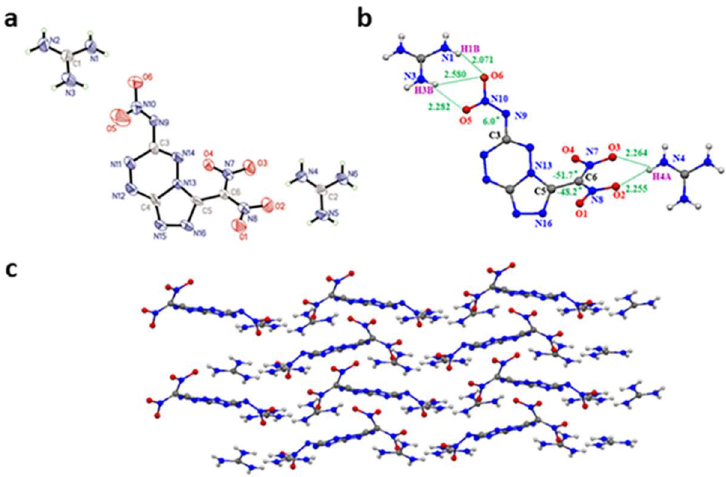
Figure 2. ( a ) Molecular structure of 3 . ( b ) Hydrogen bonds of 3 (green dash line). ( c ) Crystal packing diagram of 3 .(blue for nitrogen atoms and red for oxygen